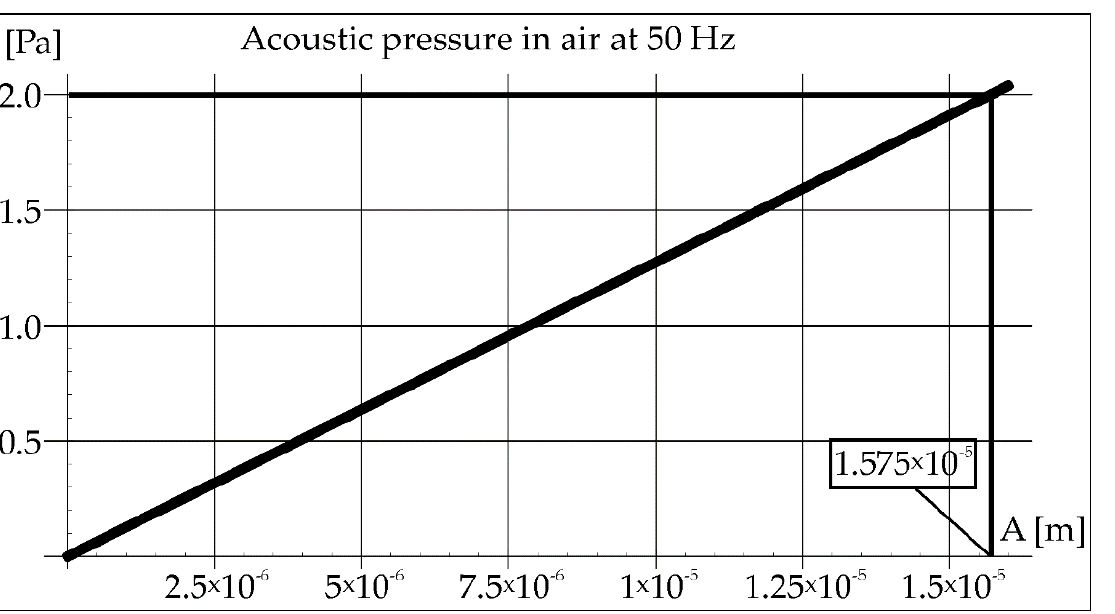
Table 1. Material and characteristic parameters of vibrations supporting laser welding. Weld No